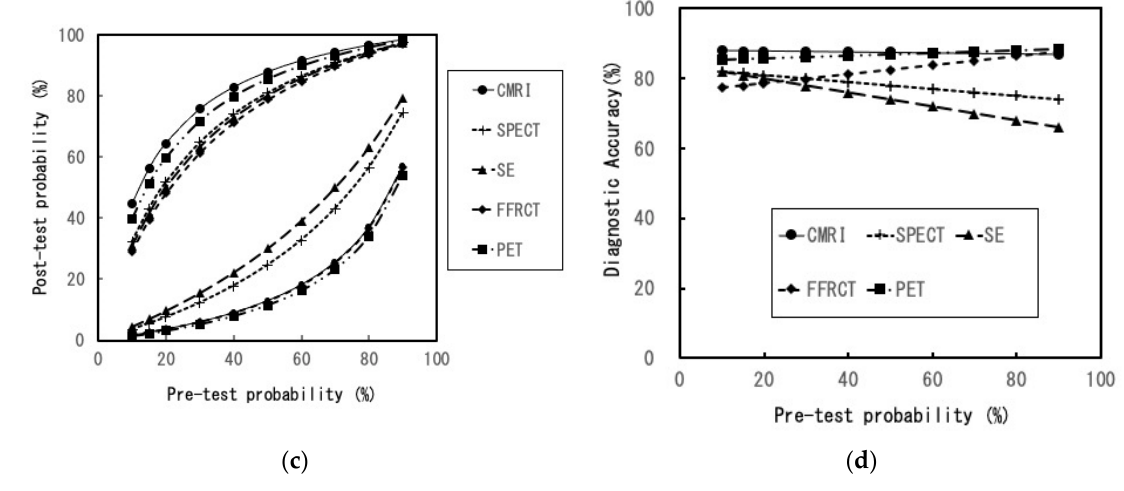
Figure 3. Sensitivity analysis (2). ( a ) Changes in PPV with various pre-test probabilities of CAD; ( b ) changes in NPV with various pre-test probabilities of CAD; ( c ) changes in post-test probability with various pre-test probabilities of CAD, Upper: post-test probability (for positive result), Under: post-test probability (for negative result); ( d ) changes in the diagnostic accuracy with various pre-test probabilities of CAD; CMRI: cardiac magnetic resonance imaging, SPECT: single-photon emission computed tomography, SE: stress echocardiography, FFRCT: fractional flow reserve derived from coronary computed tomography angiography, PET: positron emission computed tomography, CAD: coronary artery disease, PPV: positive predictive value, NPV: negative predictive value.